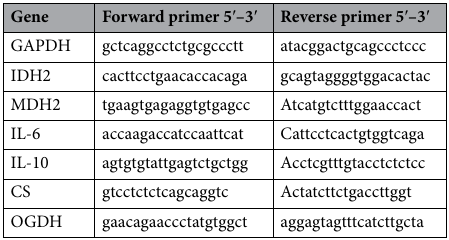
Table 1. Primer sequences for